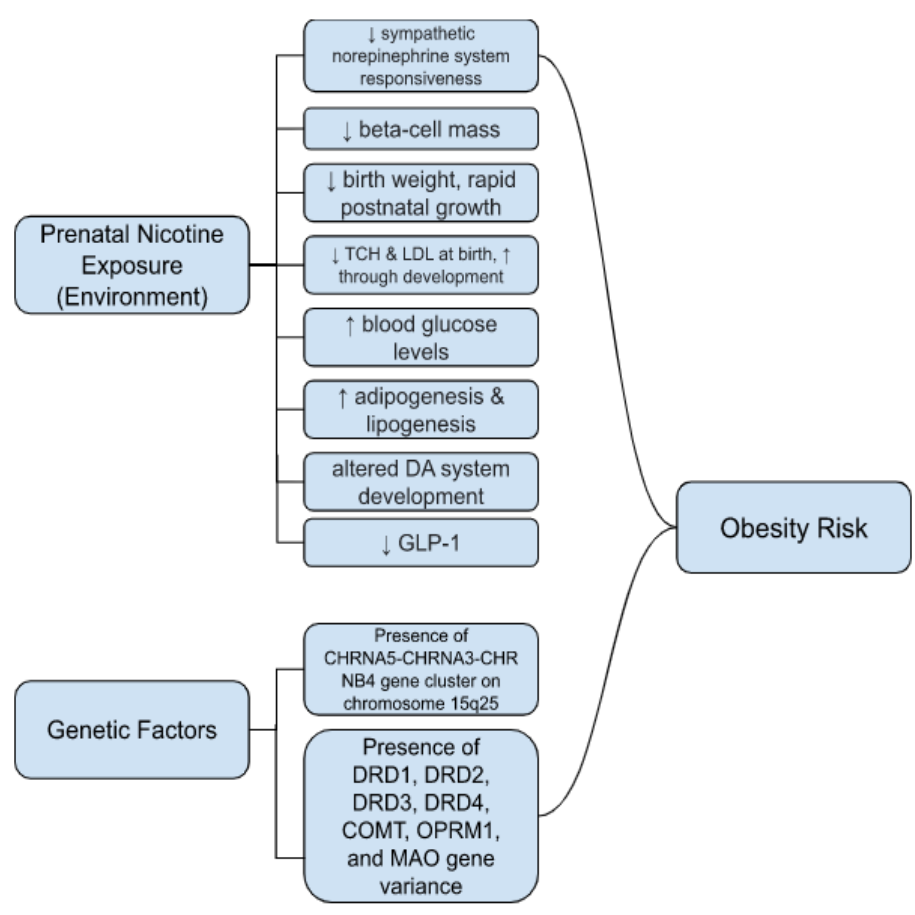
Figure 2. Summary of Physiological Effects in Offspring Prenatally Exposed to Nicotine through Maternal Smoking.